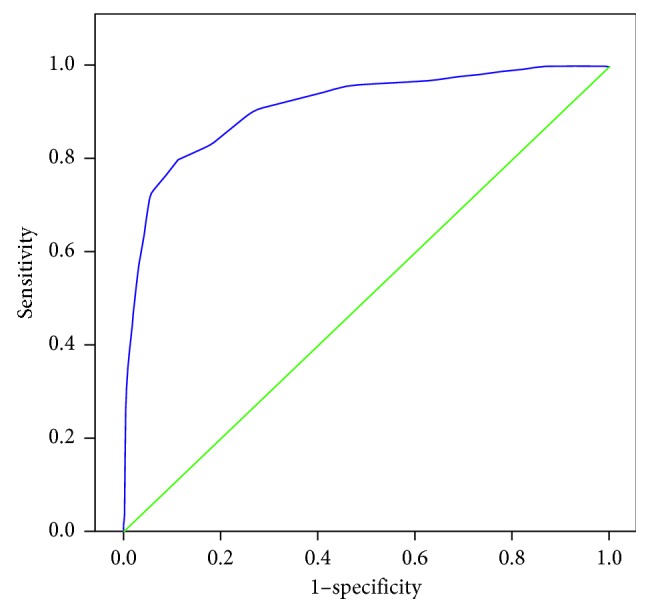
Receiver operating characteristic (ROC) curve generated with total MSNS score as the test variable to predict mortality.